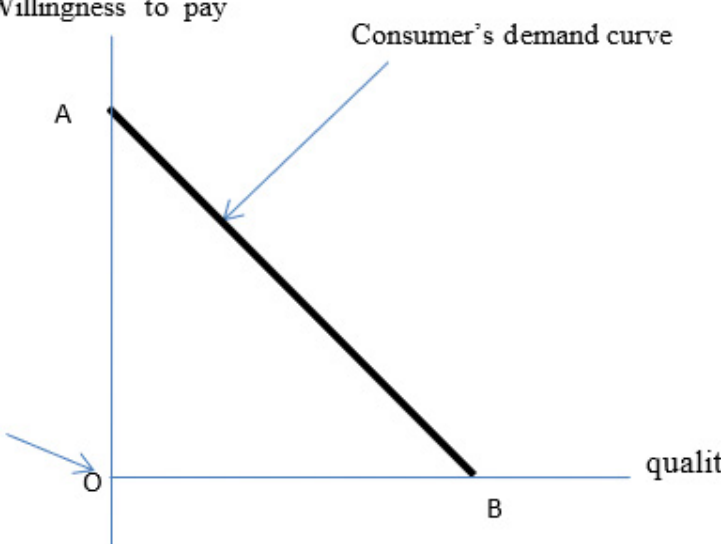
Figure 2. Zero-consumer surplus pricing in the case of complete information.